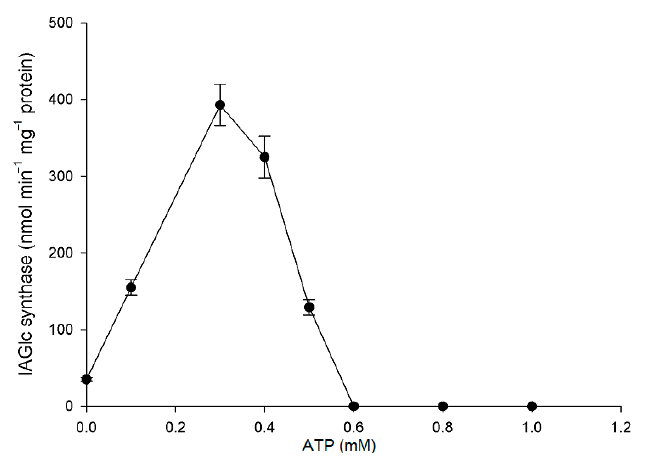
Figure 7. Effect of ATP on IAGlc synthase. The following concentrations of ATP were used for this assay: 0; 0.1; 0.3; 0.4; 0.5; 0.6; 0.8 and 1.0 mM. Enzyme activity was determined using [ 14 C]IAA after TLC. Catalytic activity was expressed as the means ± SD for three repetitions.